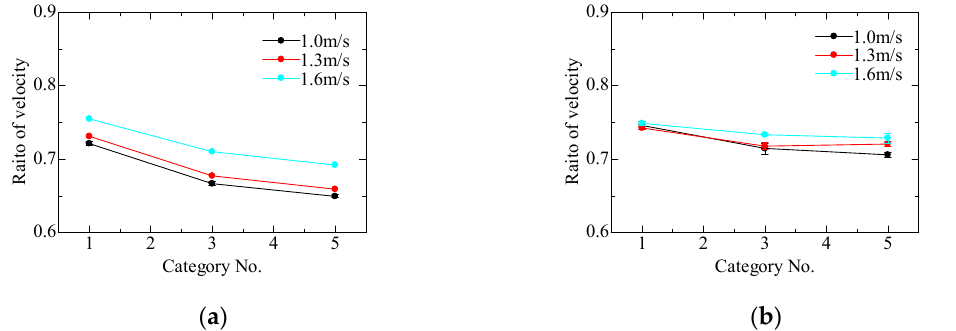
Figure 6. Experimental results of the ratio of velocity about the x axis: ( a ) blade A; ( b ) blade B. The error bars represent the standard deviation. The black, red and blue lines represent the results at impact speeds of 1.0, 1.3 and 1.6 m/s, respectively.